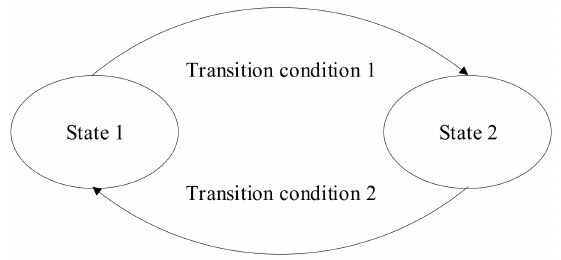
Figure 2. Failure logic diagram.